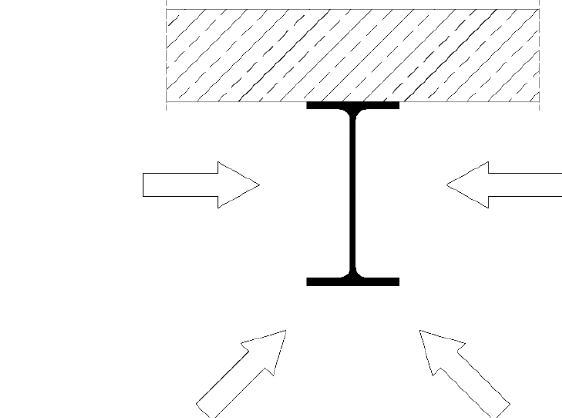
Figure 6. ISO-Standard fire curve (left graph) and fire scenario (right graph).